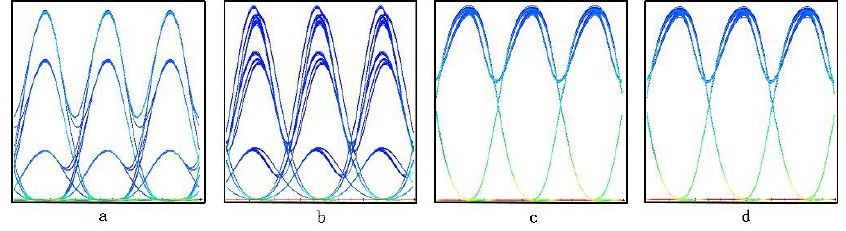
Fig. 3. Time-domain waveforms of the downlink 67% duty cycle RZ-4PAM and AMI uplink signals before and after transmission.